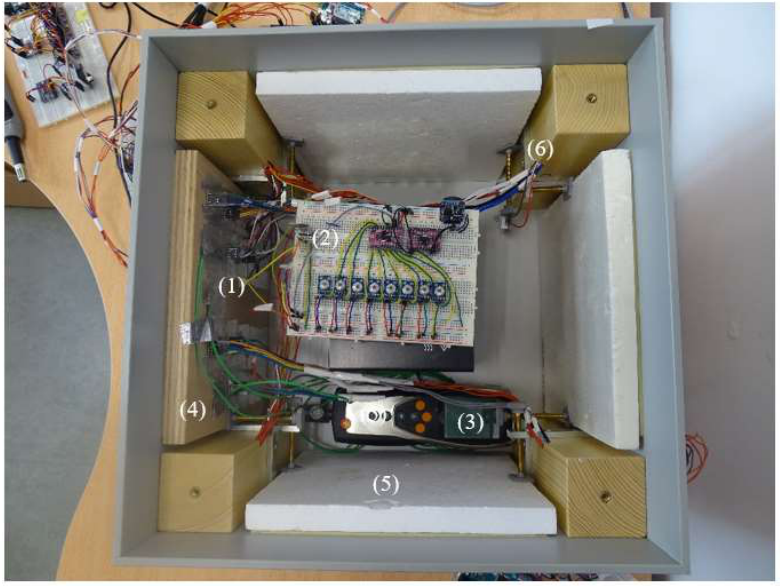
Figure 8. Installation of the contact DS18B20/MAX30205: sensors (1), infrared sensor MLX90614 (2), indoor module of TESTO 435-1 (3) and different elements of the temperature-controlled box model: plywood wall (4), polystyrene (5), corner hole (6).